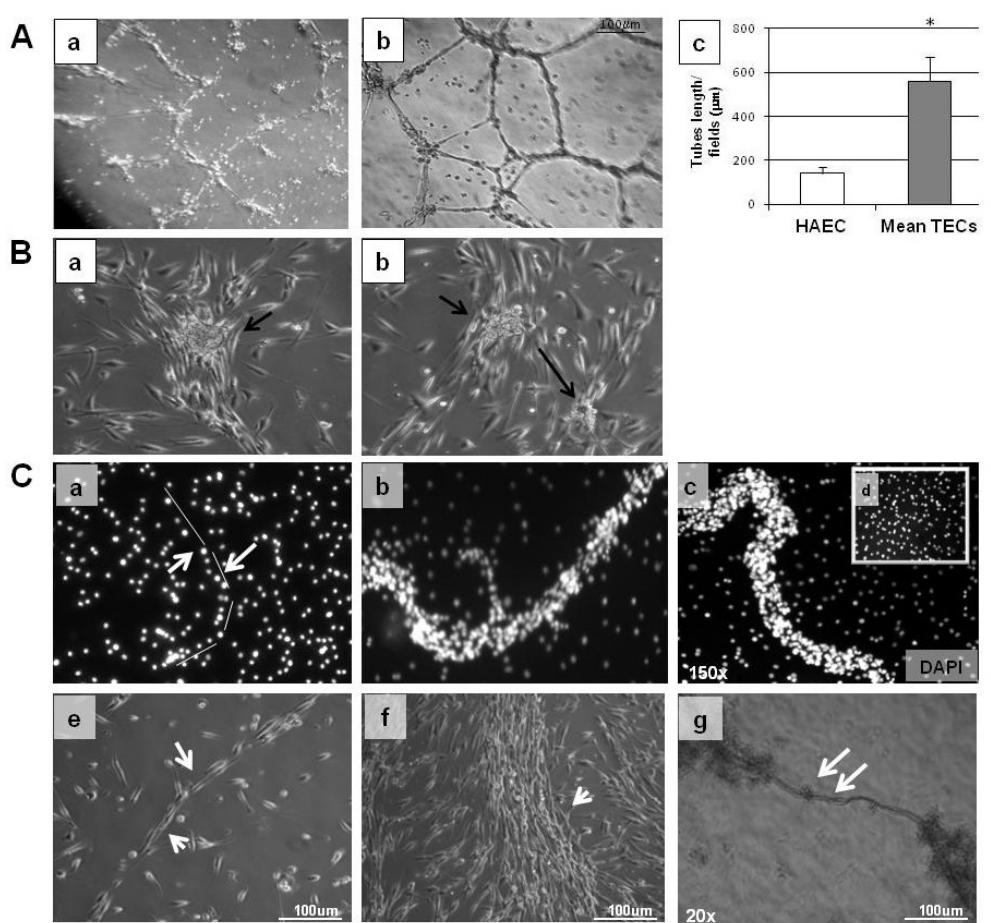
Figure 5. In vitro angiogenesis of TECs . Normal HAECs and TECs (5.0 × 10 4 cells/well) were plated on growth factor-reduced Matrigel in EGM-2 containing plus 0.2% BSA and were observed after 3 h. ( A ), ( a ) Representative micrograph of the weak network of tubes formed by HAECs in the absence of serum. ( b ) Representative micrograph of the complete network of tubes formed by TEC 2 cell line persisting for several days (20×). ( c ) Bar graph of mean tube length x fields/µm of different TEC cell lines (TEC 1 and TEC 2) evaluated by computer analysis system in 3 different fields at 20× magnification in duplicate wells of two different experimental points (* p < 0.05). ( B , a , b ) Typical examples of TEC colonies. As indicated by arrows an endothelial colony consists of a central core of rounded cells surrounded by sprouting cells. ( C ) Direct observation of spontaneous tube-forming process by endothelial bone tumor cells cultured with stromal- derived growth factor (SDF-1). ( a – c ) TEC 1 spontaneous tube formation in presence of SDF-1 stained with DAPI at different time points as indicated at 150×